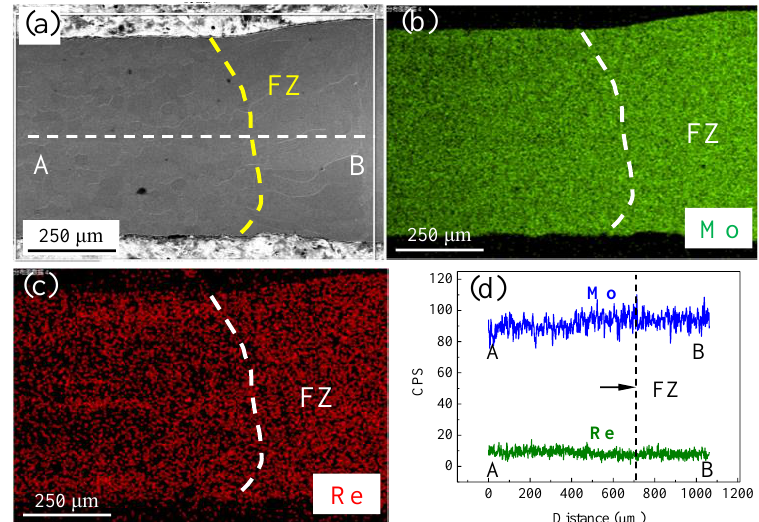
Figure 11. Result of EDS on the cross section of the joint welded using parameters 7 (0.5) #; ( a ) SEM image of the cross section; ( b ) the result of EDS area analysis of Mo; ( c ) the result of EDS area analysis of Re; ( d ) the result of EDS line scanning of Mo and Re along line AB in ( a ).